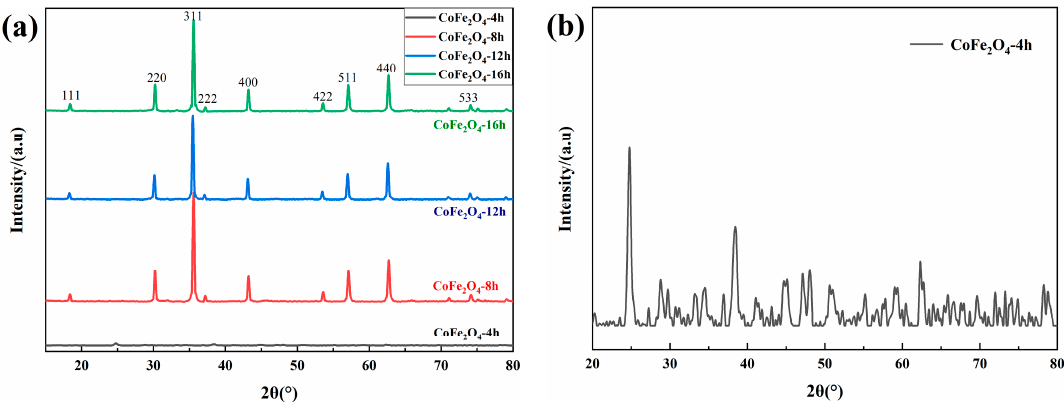
Figure 1. X-ray diffraction analyzer (XRD) pattern of cobalt ferrites; ( a ) the cobalt ferrite with different reaction time; ( b ) the product of 4h reaction time.